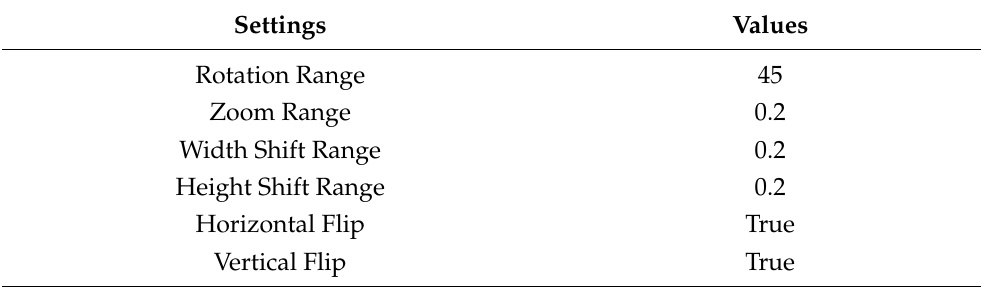
Figure 3. Data sample, data augmentation and output samples with respect to data augmentation settings. Table 2. Data augmentation arguments and their range and